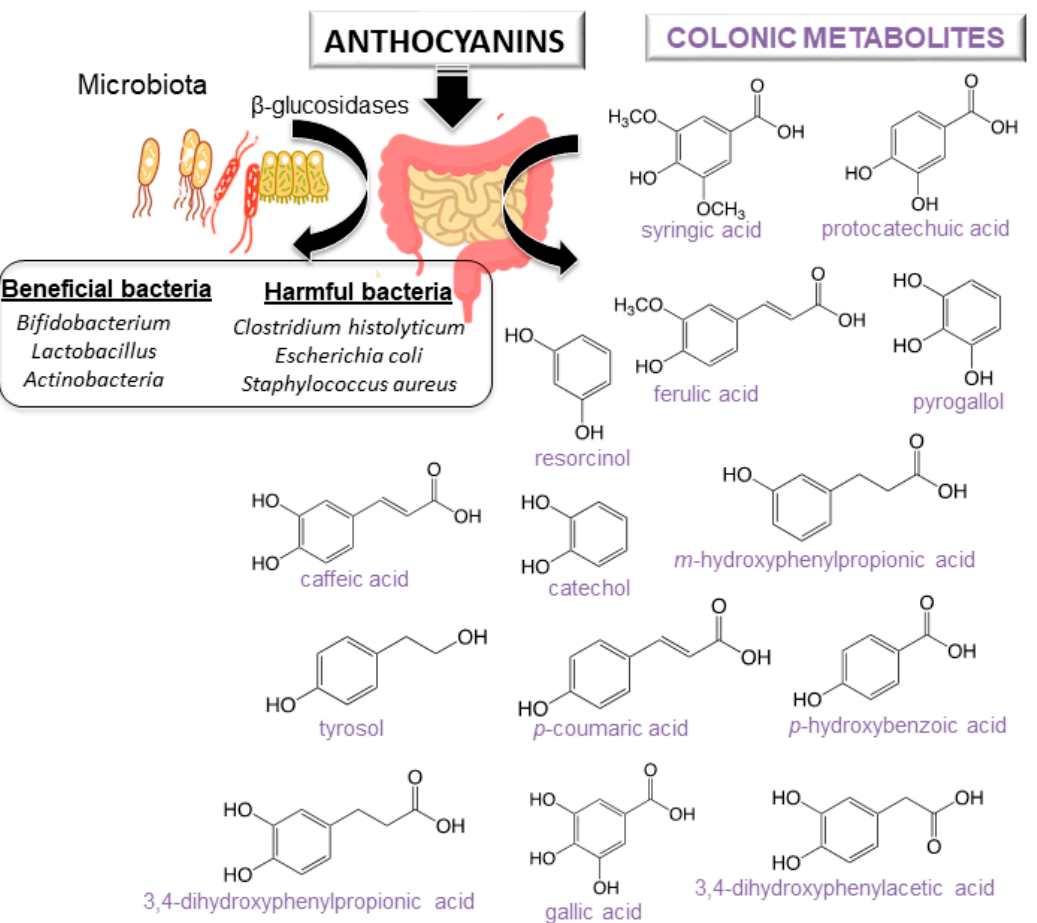
Figure 4. Scheme of anthocyanins metabolites from colonic metabolism and colon microbiota alteration.